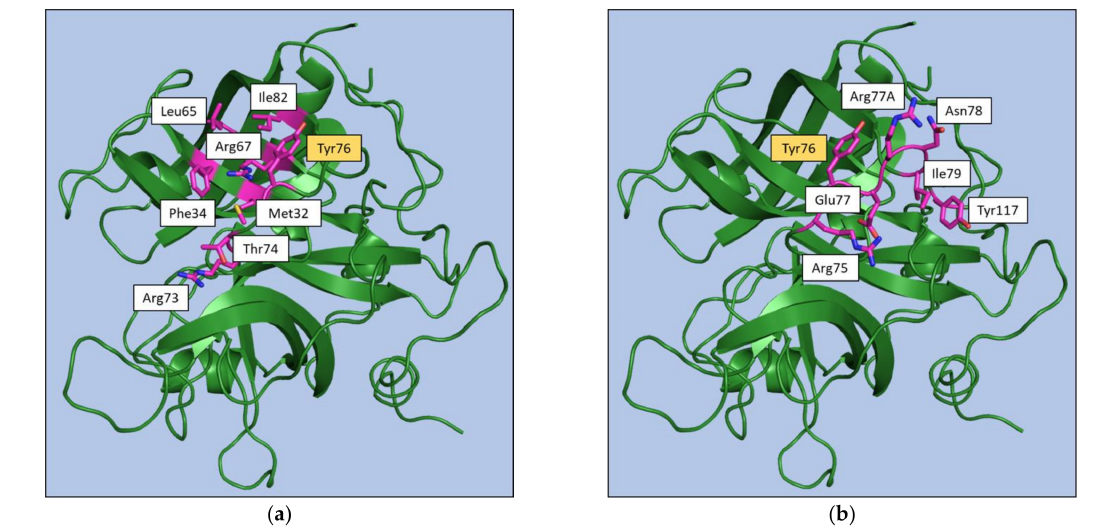
Figure 8. Exosite I residues involved in interaction of thrombin with at least the 50% of ( a ) non-aptamer or ( b ) aptamer ligands. Tyr76 is highlighted in yellow as it has been found in both classes.